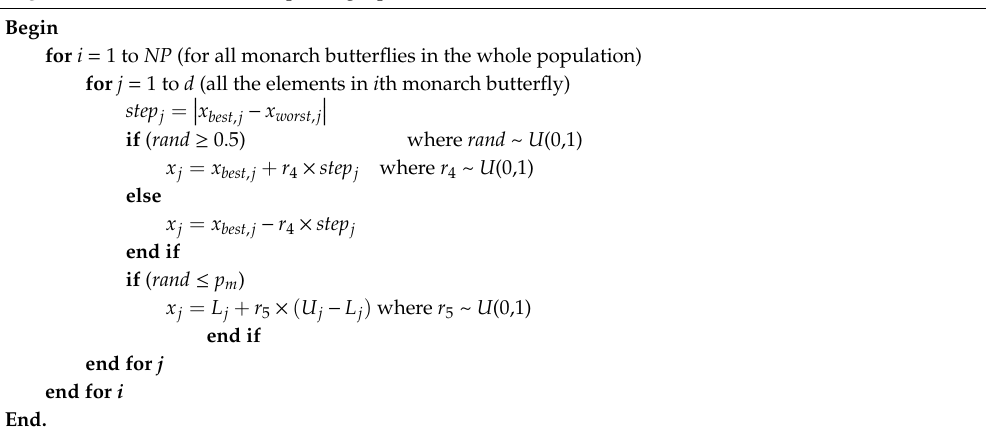
Algorithm 3. Global Position Updating Operator